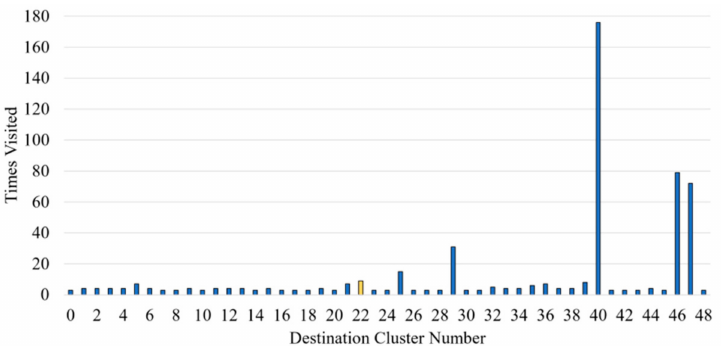
Figure 2. Number of journeys reaching each specific destination cluster. A destination where one journey was removed prior to model training (yellow) is used as an unseen full journey